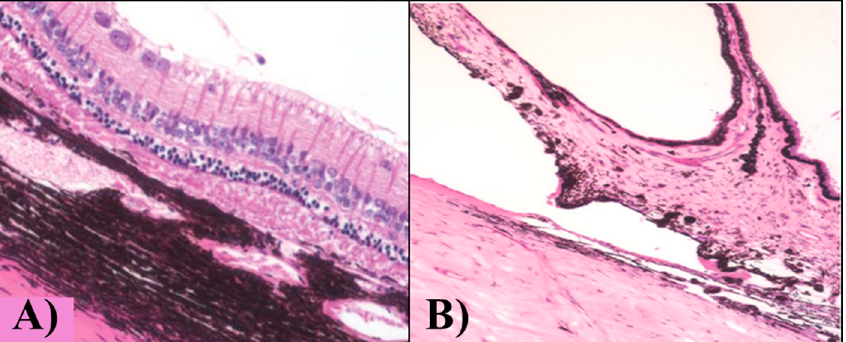
Figure 8. Light microscopy of the rabbit eye ( A ) retina and ( B ) anterior chamber after 6 months of intravitreal injection of PNIPAAm hydrogel. Ganglion cell layer and iris tissue are both facing upwards in (A) and (B). Reprinted with permission from reference [49]. Copyright © 2016 Hindawi Publishing Corporation (Cairo, Egypt).